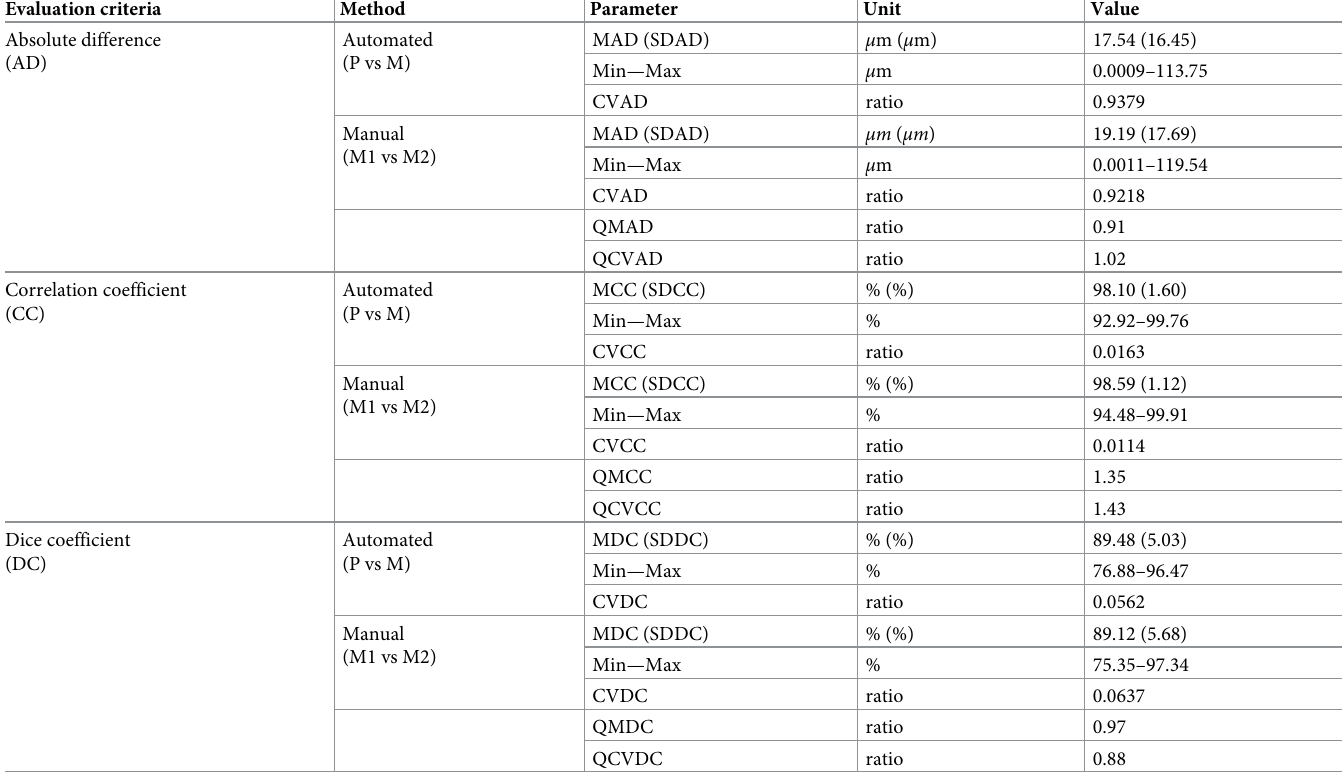
Table 1. Statistical analysis: Automated vs manual methods. Notation: M1-manual segmentation-1, M2-manual segmentation-2, M-average of M1 and M2, P-proposed, M q -mean, SD q -standard deviation, CV q -coefficient of variation, QM q -quotient of mean, QCV q -quotient of coefficient of variation, q takes AD, CC or DC. Evaluation